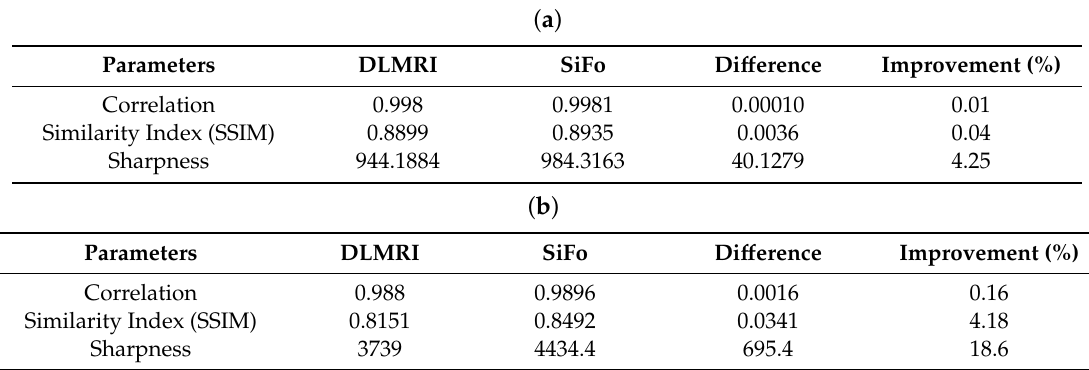
Table 1. Performance parameter (SiFo vs DLMRI) of algorithm with noiseless case for ( a ) Brain image ( b ) Phantom image.